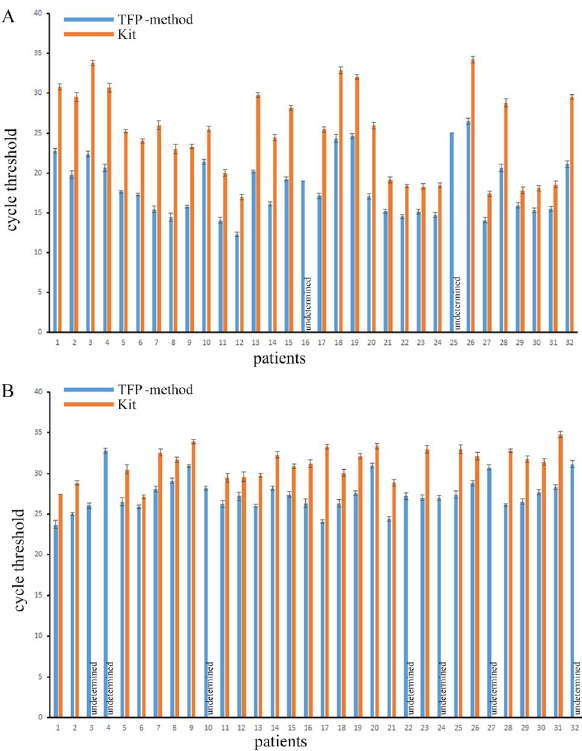
Figure 4. The specific CT values of pfeRNA of 34 nt ( A ) and 53 nt ( B ) from 32 clinical specimens. Three microliters of the synthesized cDNA, in a total volume of 20 µl, was used for qPCR detection. Undetermined means the levels of the target could not be detectable. All values are averages of six CT values from three independent repeats, and the error bars reflect the mean